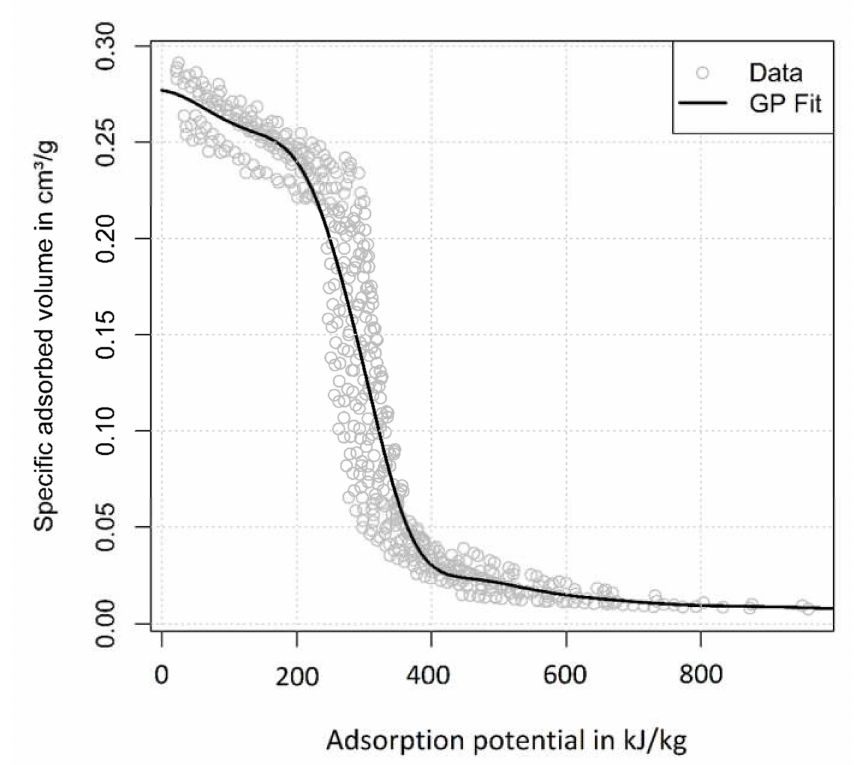
Figure 2. Measured adsorption equilibrium data in Dubinin’s representation (grey circles: mea- sured pressure p, temperature T, and loading X transformed into specific adsorbed volume W and adsorption potential A) and Gaussian Process (GP) Regression of the dataset (black